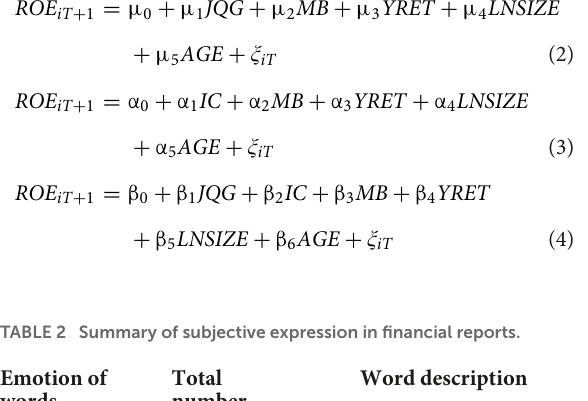
FIGURE3 Research framework for exploring the relationship between subjective expression in financial reports and company performance.